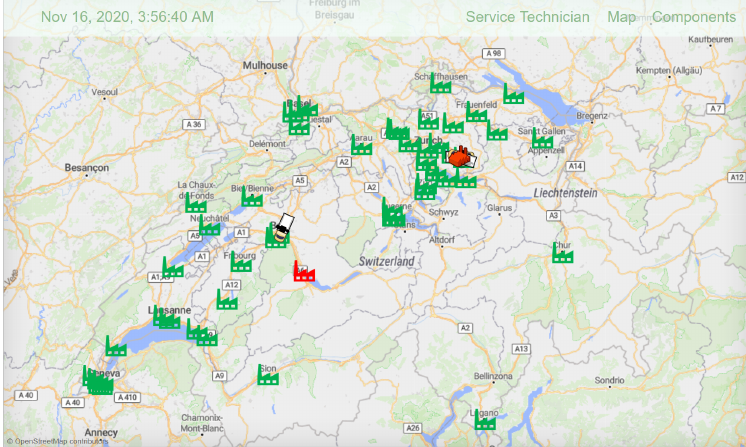
Figure 12. Main Agent of Process Twin with GIS